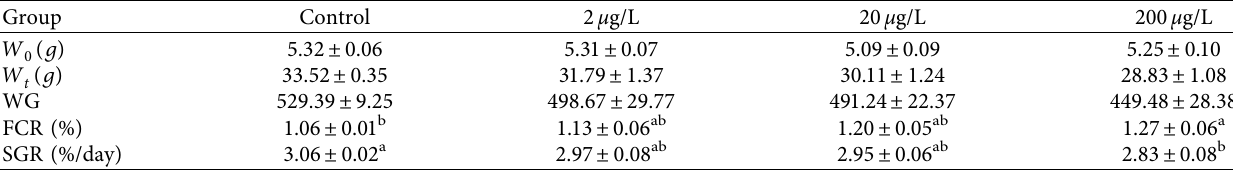
Table 1: The effects of biological parameters under different concentrations of MET